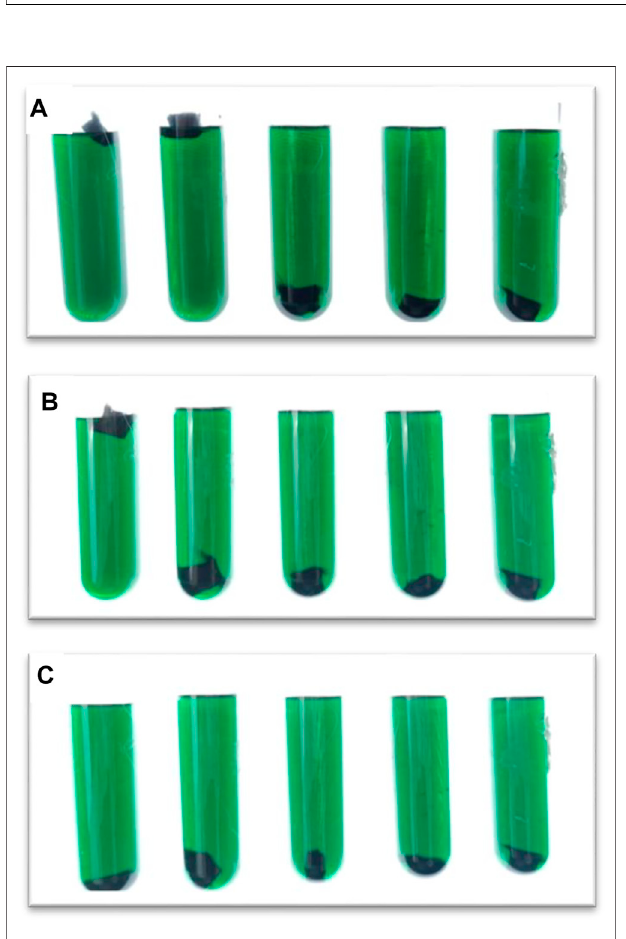
FIGURE 4 | Samples from left to right are untreated graphite felt, heat- treated graphite felt, heat-treated graphite felt after immersion in 0.1 M InCl 3 solution, heat-treated graphite felt after immersion in 0.2 M InCl 3 solution, and heat-treated graphite felt after immersion in 0.3 M InCl 3 solution, (A), momentary Contact; (B), soak for 10 min; (C), soak for 30 min.